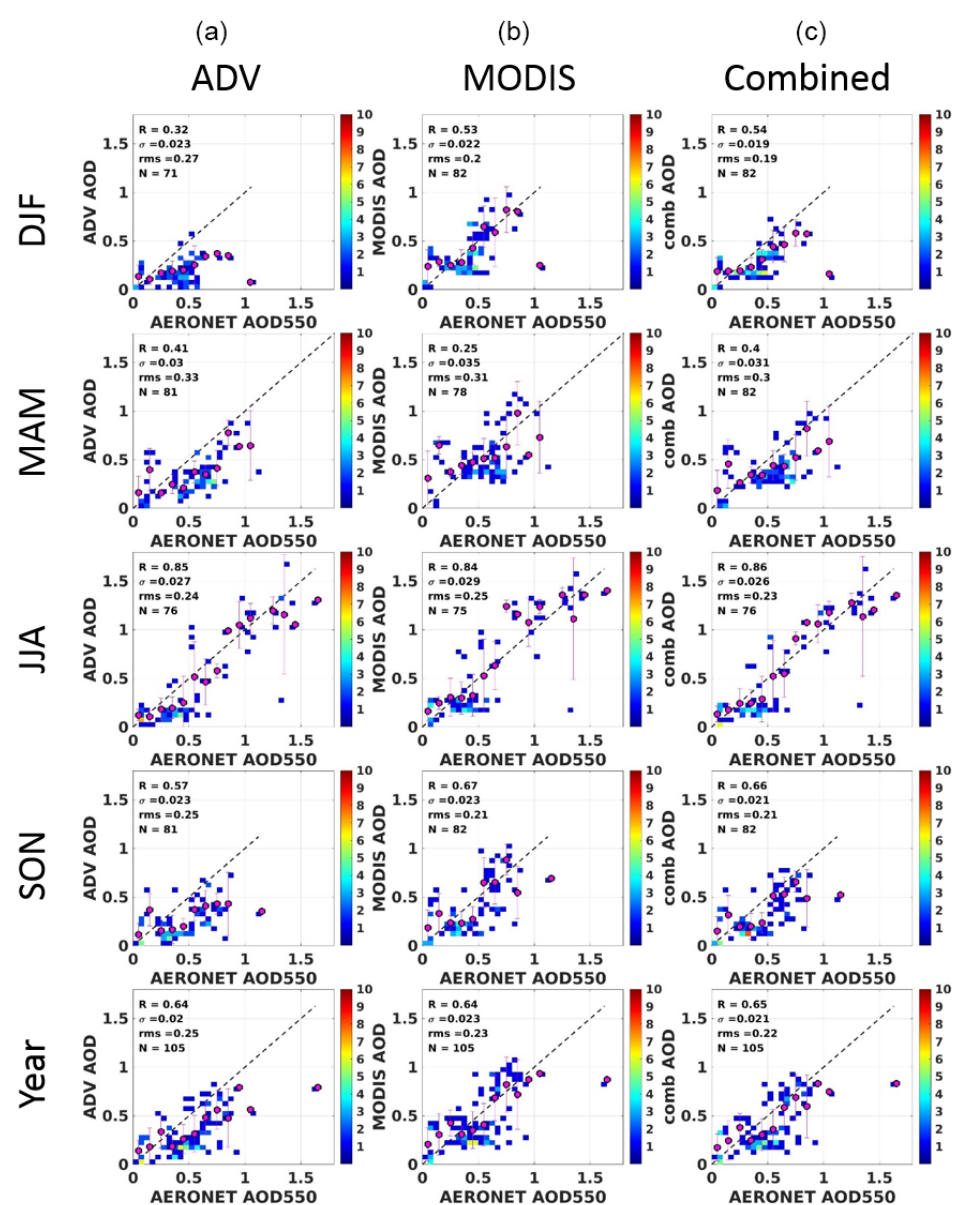
Figure 5. Density scatterplot of ADV AOD (a) , MODIS AOD (b) and combined AOD (c) versus AOD from AERONET stations over China for the T2 period (2000–2011). The filled circles are the averaged AOD binned in 0.1 AERONET AOD intervals (0.25 for AERONET AOD > 1 . 0) and the vertical lines on each circle represent the 1 σ standard deviation. Statistics in the upper left corner indicate correlation coefficient R , standard deviation, root mean square error (rms) and the number of data points ( N ). The color bar on the right indicates the number of data points in each